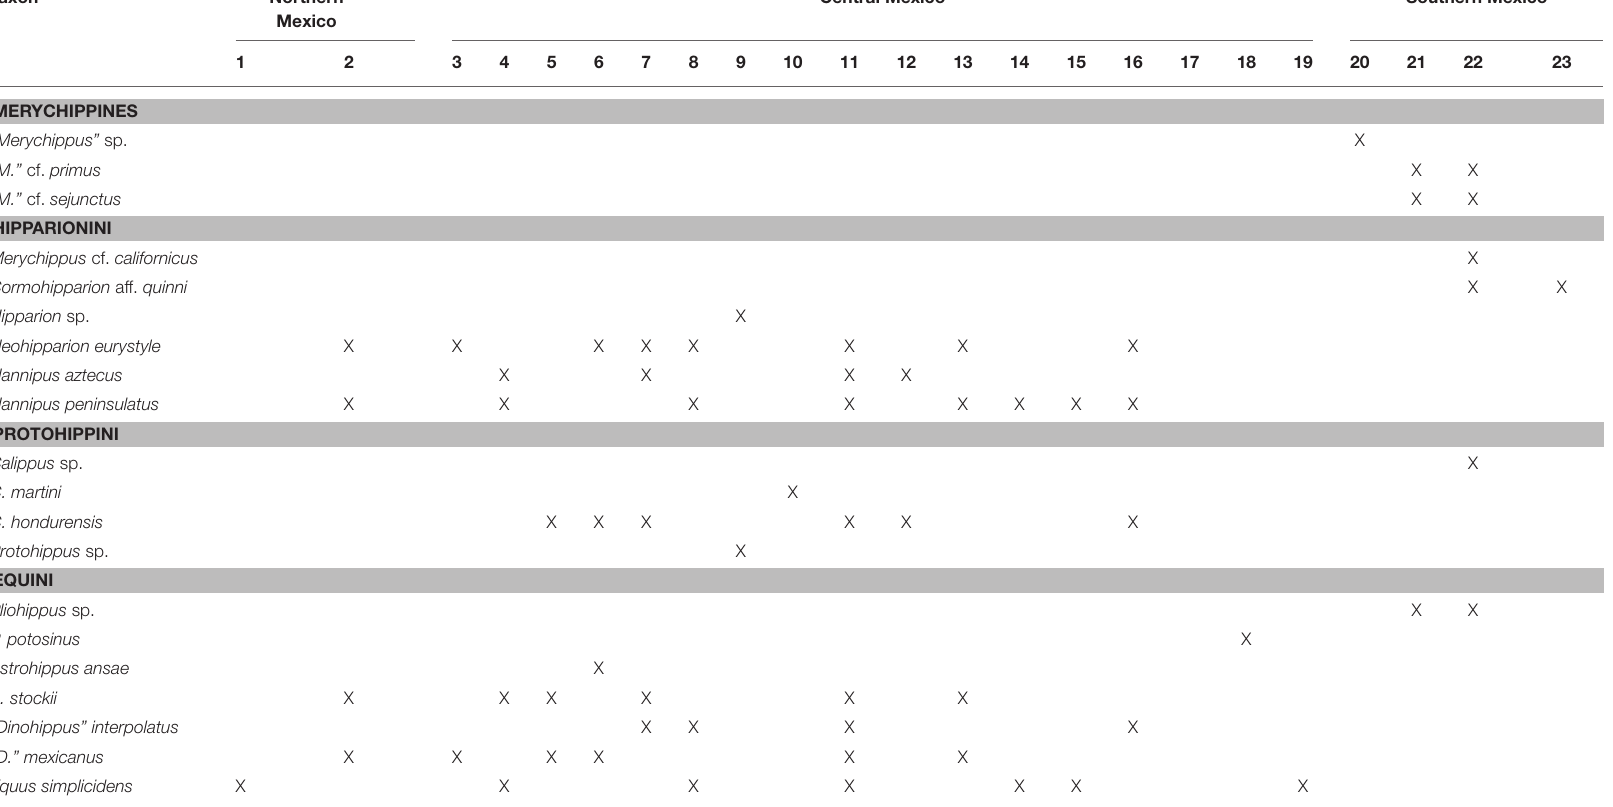
TABLE 1 | List of localities that bear fossil material belonging to Equinae from the Mexican Neogene. Taxon Northern